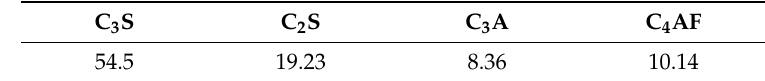
Table 3. Mineral composition of